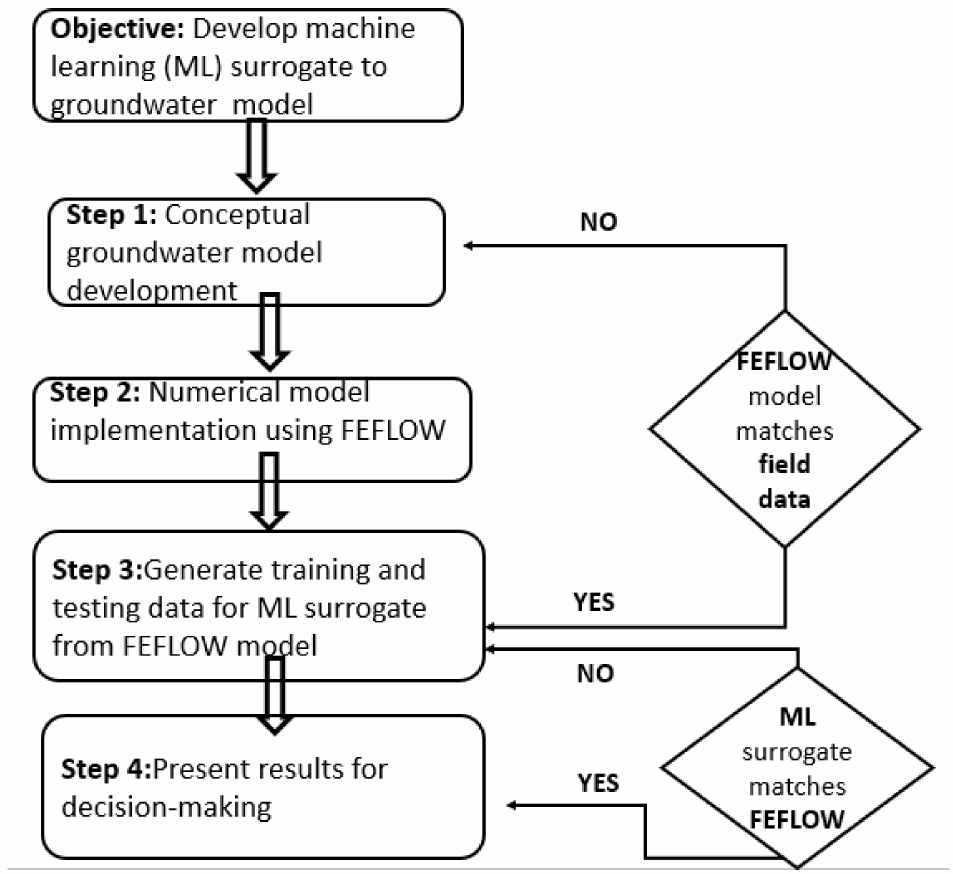
Figure 3. Flowchart showing the methodology used to meet the objective of developing an accurate ML surrogate for steady-state hydraulic head